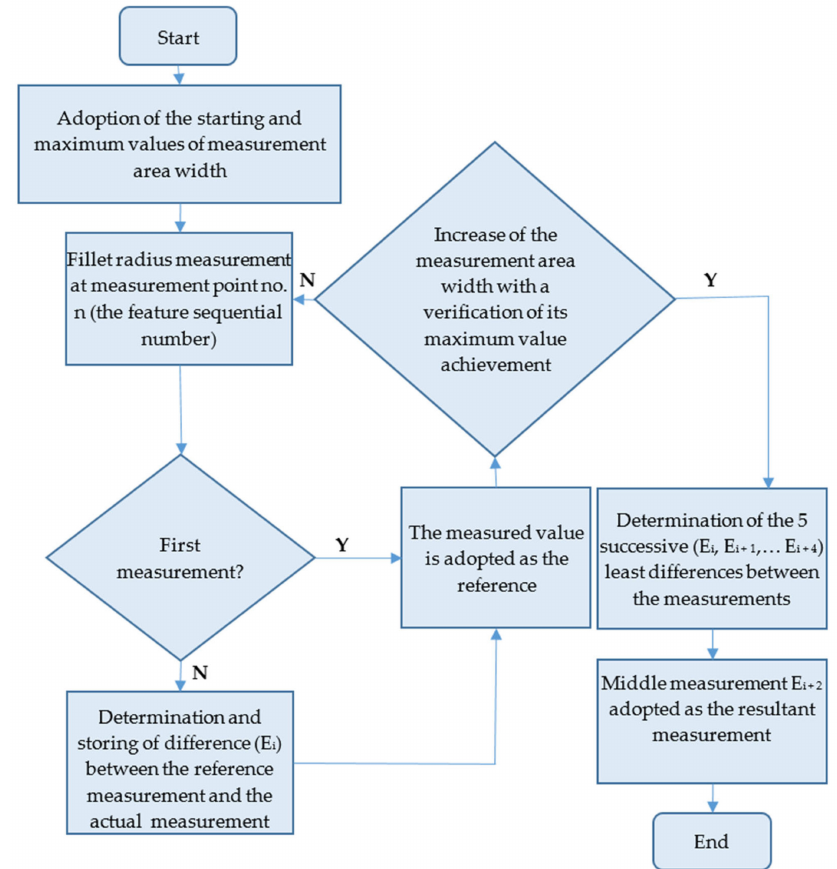
Figure 19. Algorithm for the fillet radius determination with varying measurement area width.